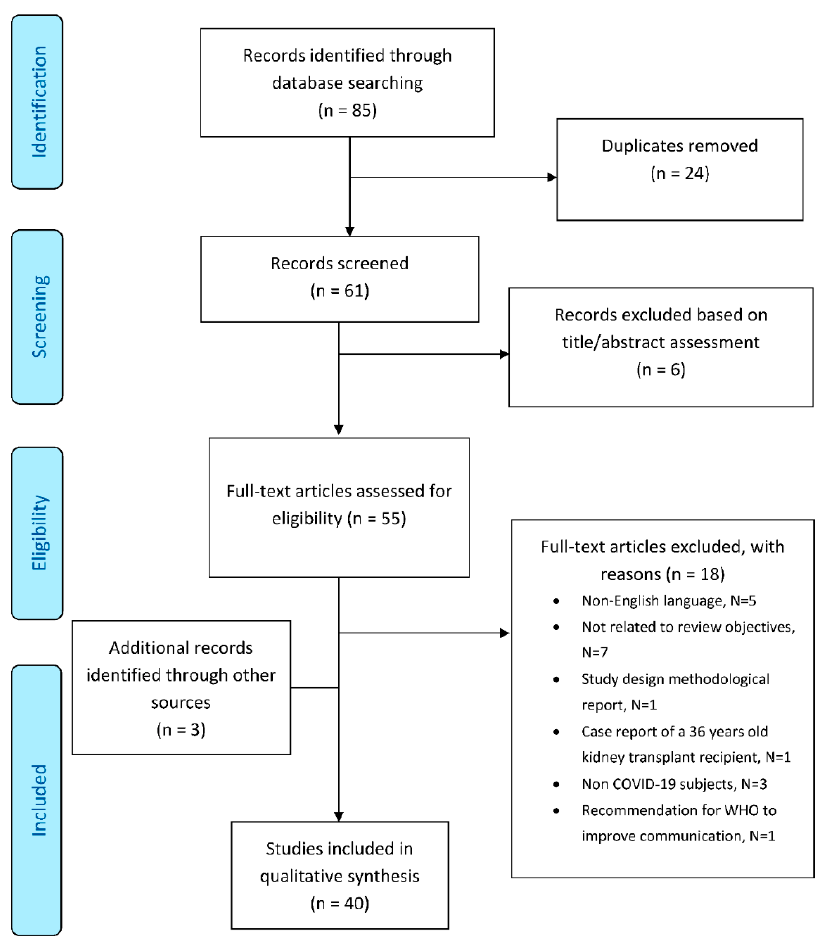
Figure 1. Scoping literature review flow-chart (PRISMA).